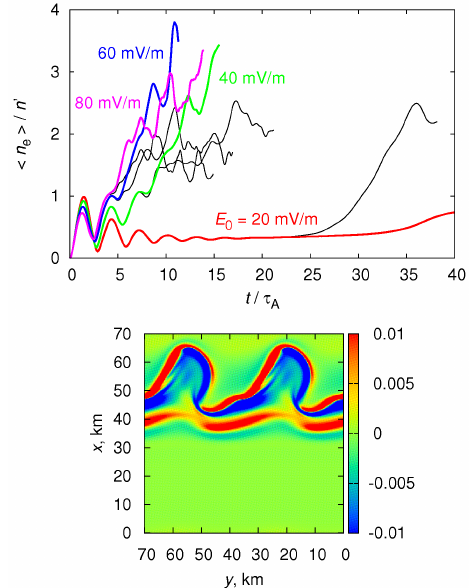
Figure 7. Upper panel: time variation in (cid:104) n e (cid:105) at the ionosphere s = 0 for E 0 = 20, 40, 60, and 80mVm − 1 in the case of (k x ,k y ) = ( 1 , 2 ) ; black lines are those shown in Fig. 6. Lower panel: vorticity ω(s = 0 ) at t/τ A = 7 . 6 for E 0 = 60mVm − 1